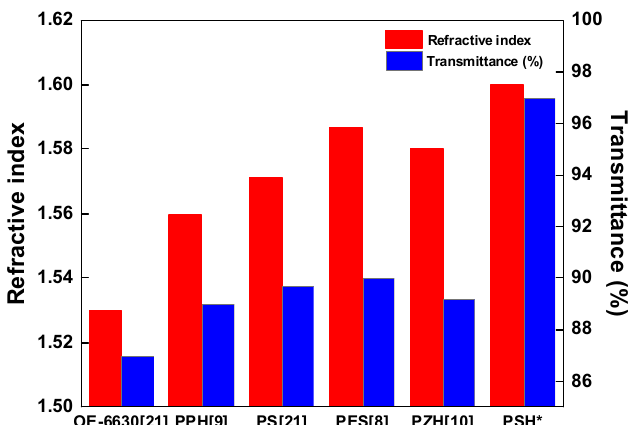
Figure 6. Refractive index and transmittance at 450 nm for the OE-6630 (Dow Corning), PPH, PS, PES, PZH, and PSH * indicates this work.